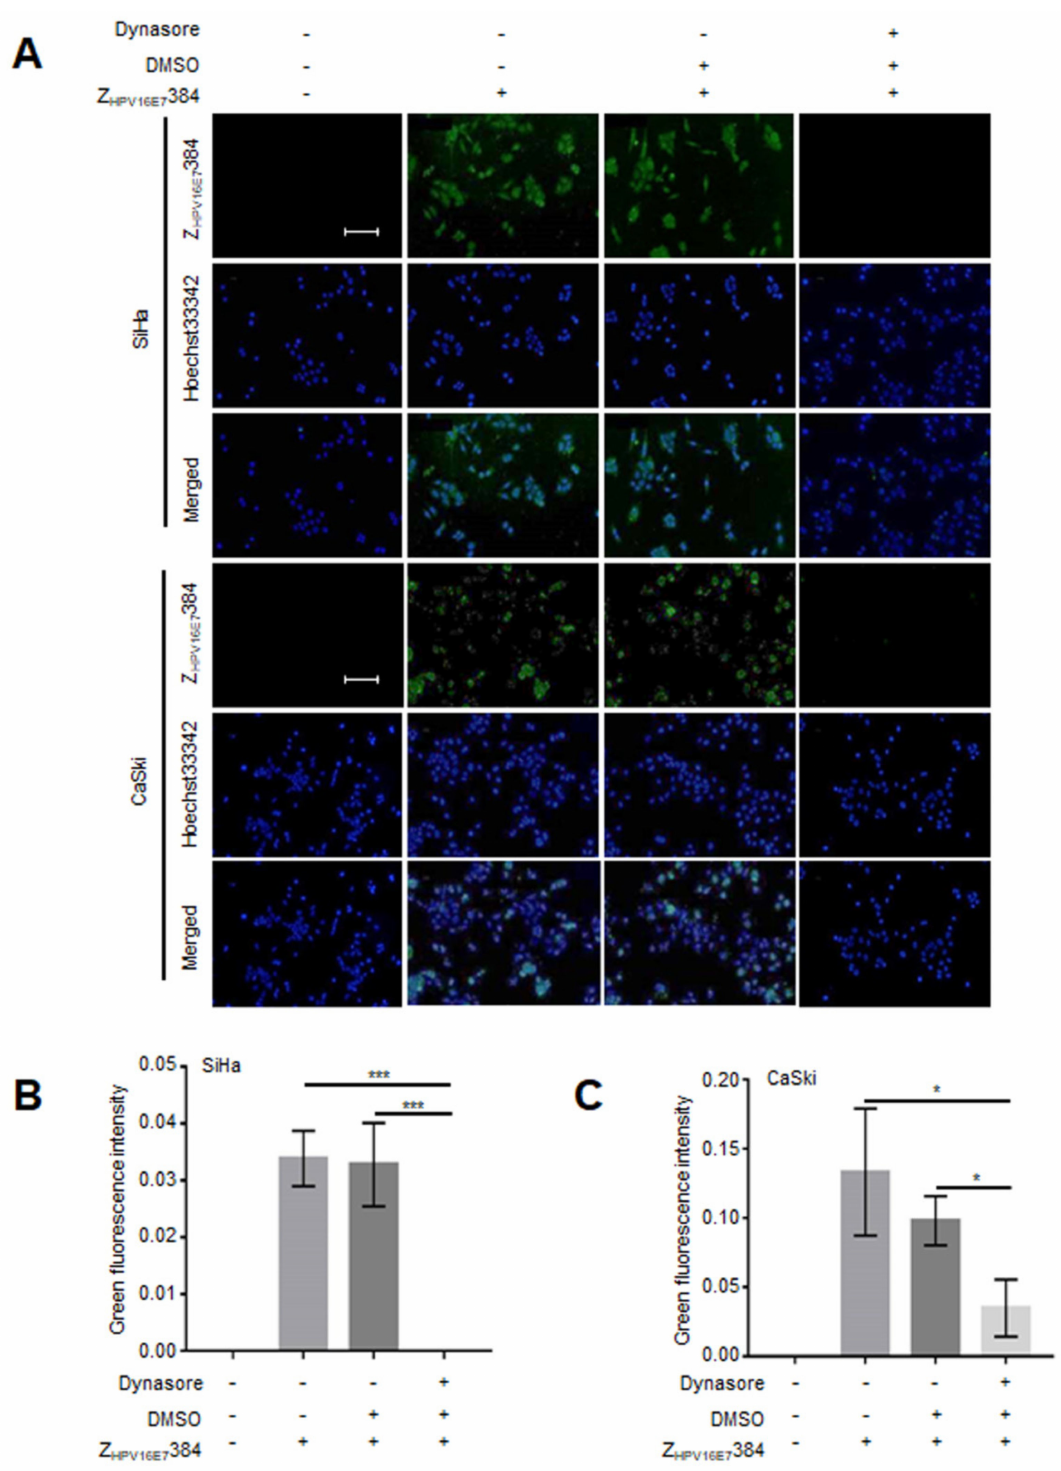
Figure 5. The Z HPV16E7 384 internalization was dependent on Dynamin. ( A ) The SiHa and CaSki cells that were first treated with the dynamin inhibitor Dynasore in DMSO and then incubated with Z HPV16E7 384 were analyzed by IFA (green). Cell nuclei were counterstained with Hoechst33342 (blue). Scale bar = 100 µ m. ( B , C ) The intensity of the green fluorescence in ( A ) was analyzed. The data shown are representative of three independent experiments. All experiments were performed in triplicate and data are expressed as the means ± SD ( n = 3). * p < 0.05, *** p <